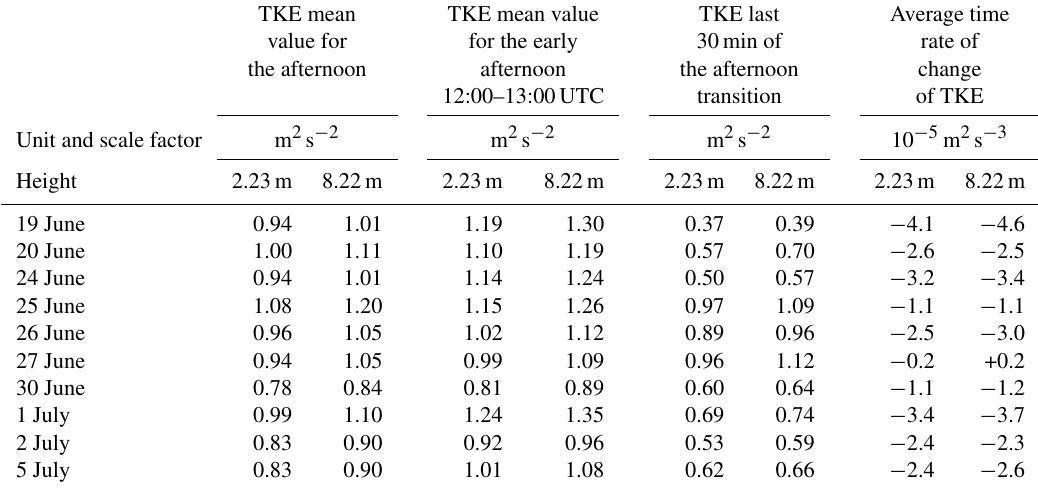
Table B3. Afternoon TKE statistics for the 10 IOP days for measurement heights of 2.23 and 8.22m. TKE mean values are shown for the afternoon, for early afternoon (between 12:00 and 13:00UTC) and for the last 30min of the afternoon transition. Also shown is the average TKE tendency for each afternoon (note the scale factor of 10 − 5 for the column on the